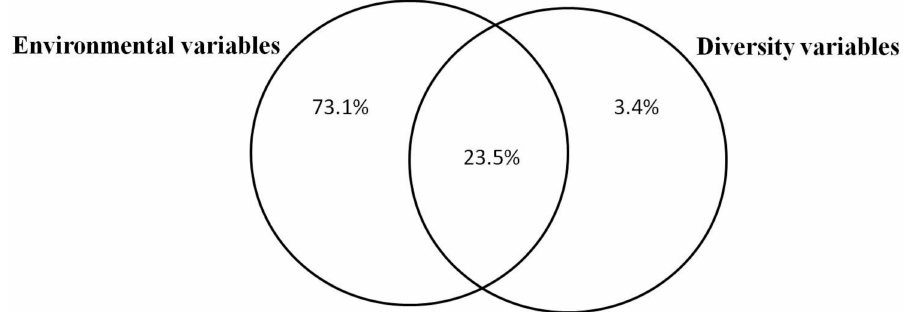
Figure 2. Distribution of the explained variation of the two sets of variables. Environmental variables (climatic, management and soil variables): mean minimum air temperature (MTmin), Temperature seasonality index of Sebasti à (TSIS = mean summer air temperature—mean annual air temperature), pH, moisture, sheep and cattle grazing. Plant functional diversity variables: Forb, Grass, Legume; forb-grass (FG), forb-legume (FL), and grass-legume (GL) pairwise interactions. Table 2. Conditional and simple term e ff ects of the Redundancy Analysis (RDA) analyses. The % explained shows the percentage of variability explained by each variable. The explanatory variables include environmental (climatic, management and soil) and plant functional diversity variables: FG = pairwise interactions of forbs and grasses; FL = pairwise interactions of forbs and legumes; GL = pairwise interactions of grasses and legumes; MTmin = mean annual minimum air temperature. Conditional term e ff ects refer to the unique e ff ects of each set of variables unlike the simple e ff ects, which refer to the simple marginal e ff ects of each set of